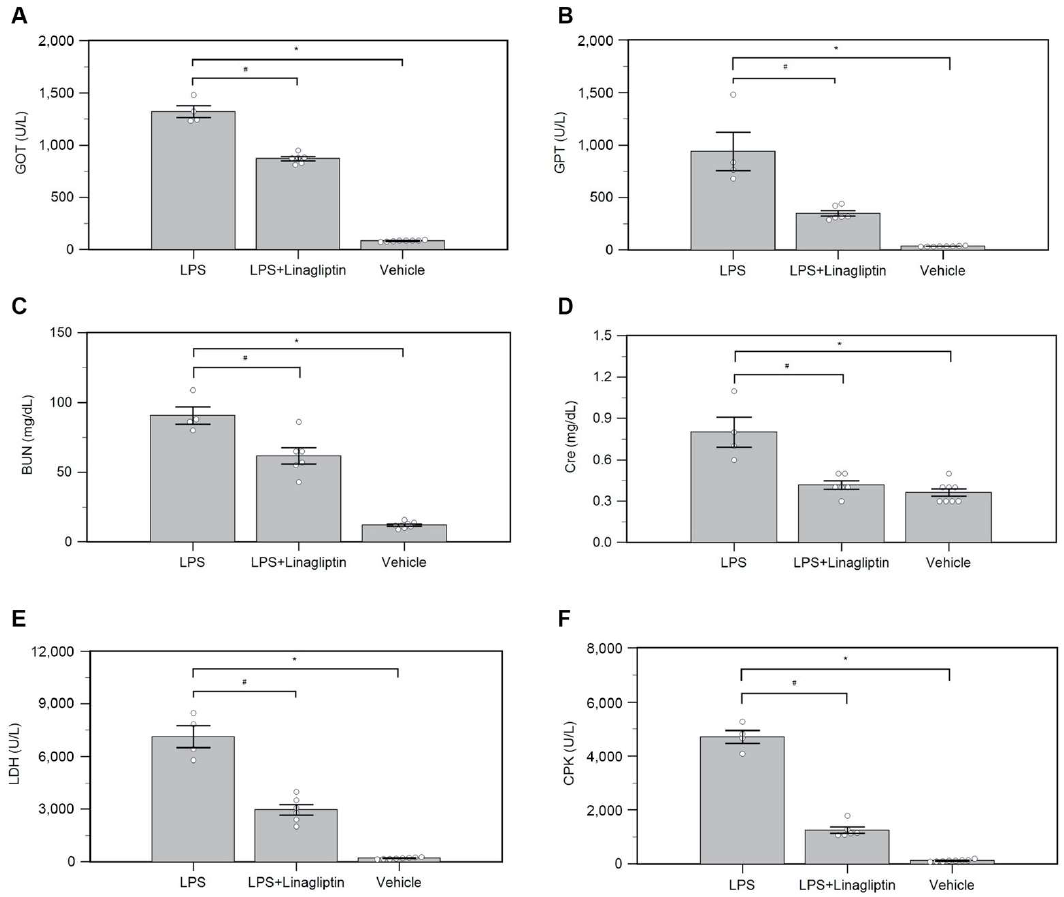
Figure 5. Changes in serum ( A ) glutamic oxaloacetic transaminase (GOT), ( B ) glutamic pyruvic transaminase (GPT), ( C ) blood urea nitrogen (BUN), ( D ) creatinine (Cre), ( E ) lactic dehydrogenase (LDH), and ( F ) creatine phosphokinase (CPK) after endotoxic shock in conscious rats. * p < 0.05 for the LPS group compared with the Vehicle group. # p < 0.05 for the LPS + Linagliptin group compared with the LPS group. Vehicle ( n = 8), LPS ( n = 4), and LPS + Linagliptin ( n = 6) groups at 48 h after LPS administration.